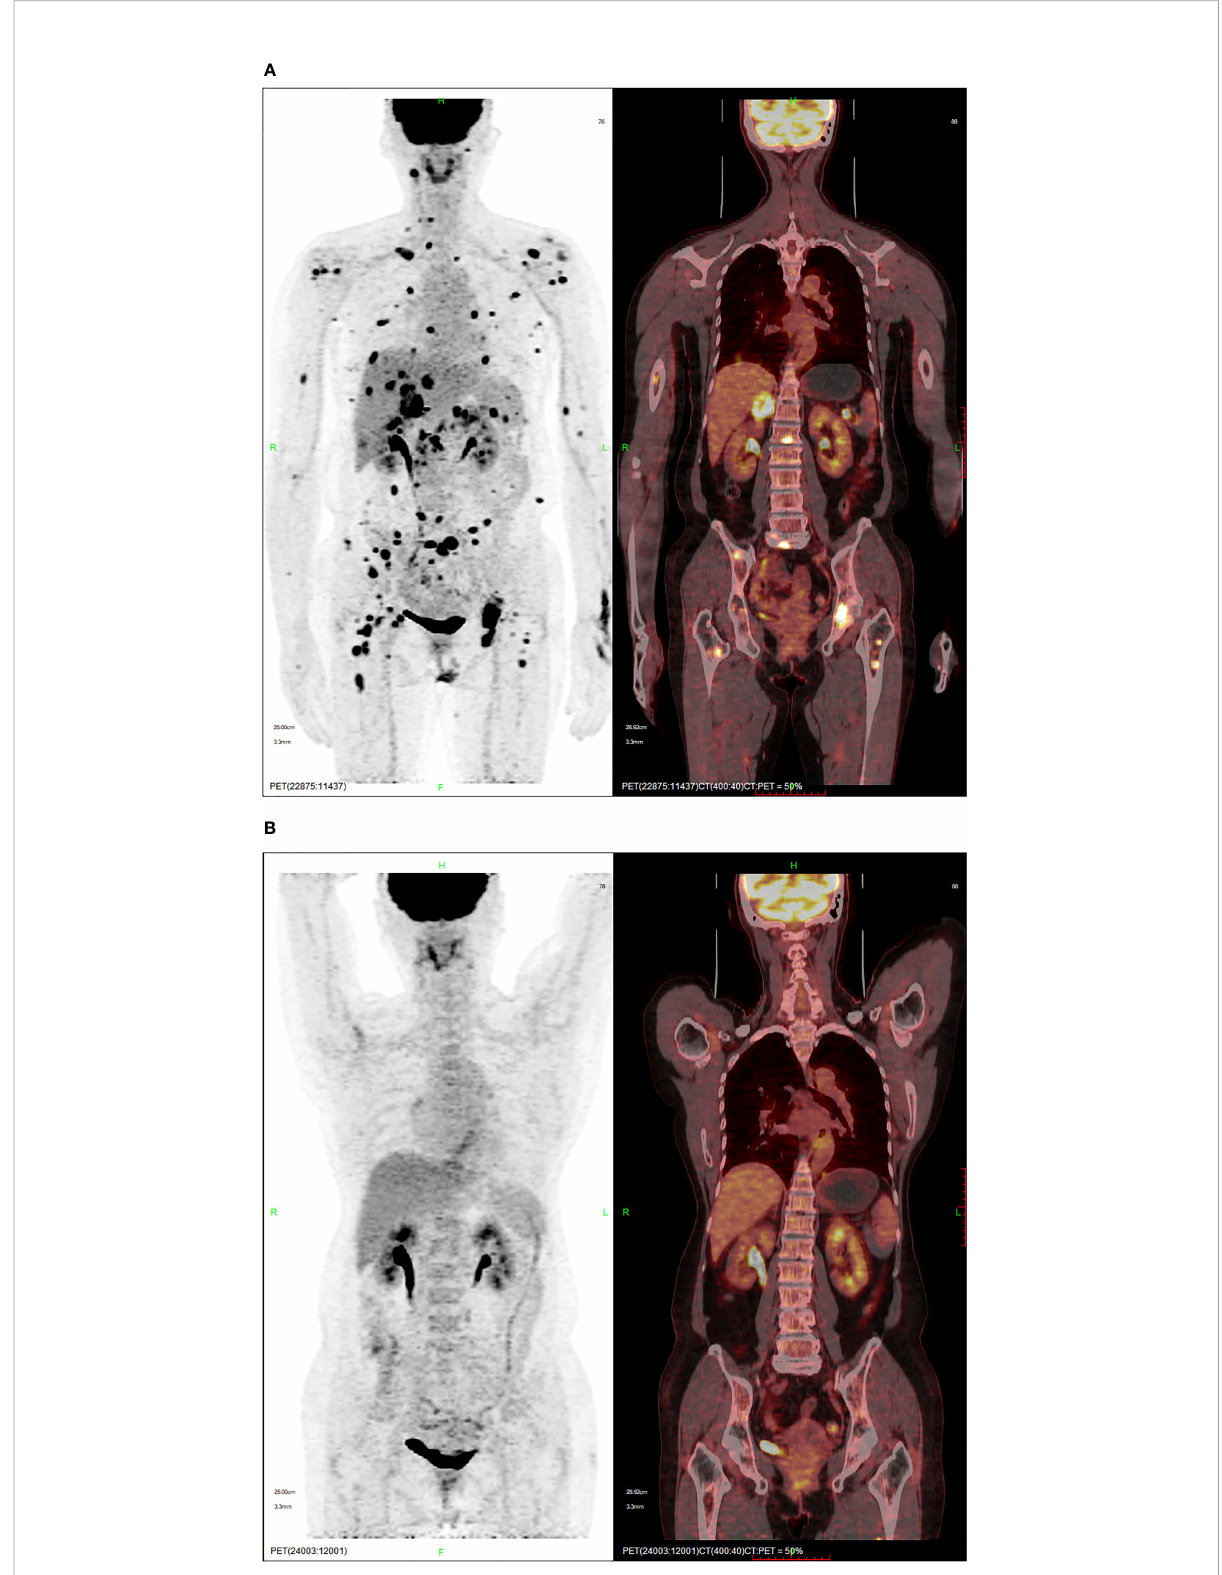
FIGURE 2 PET-CT showing (A) the lesion and high FDG uptake in November 2020, and (B) complete remission following crizotinib in August